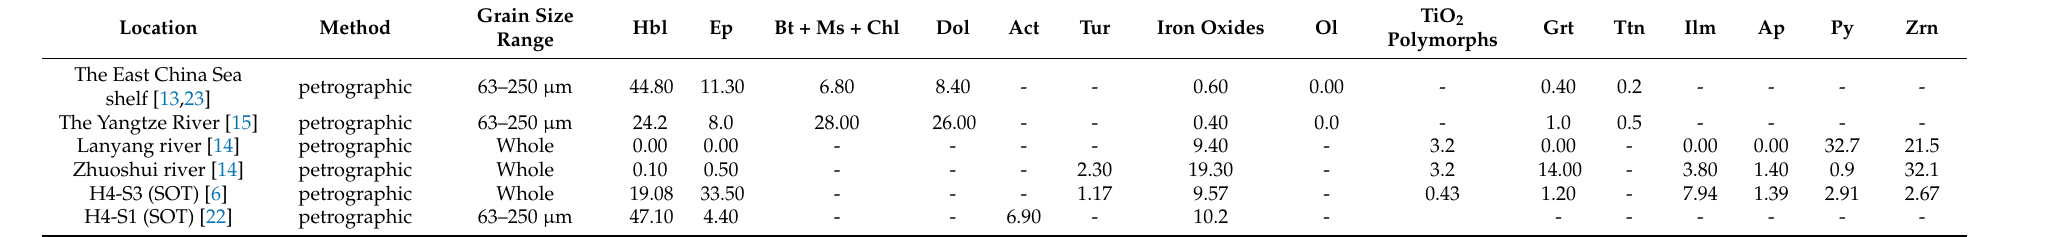
Table 3. Heavy mineral assemblages in the potential provenance area of the southern Okinawa